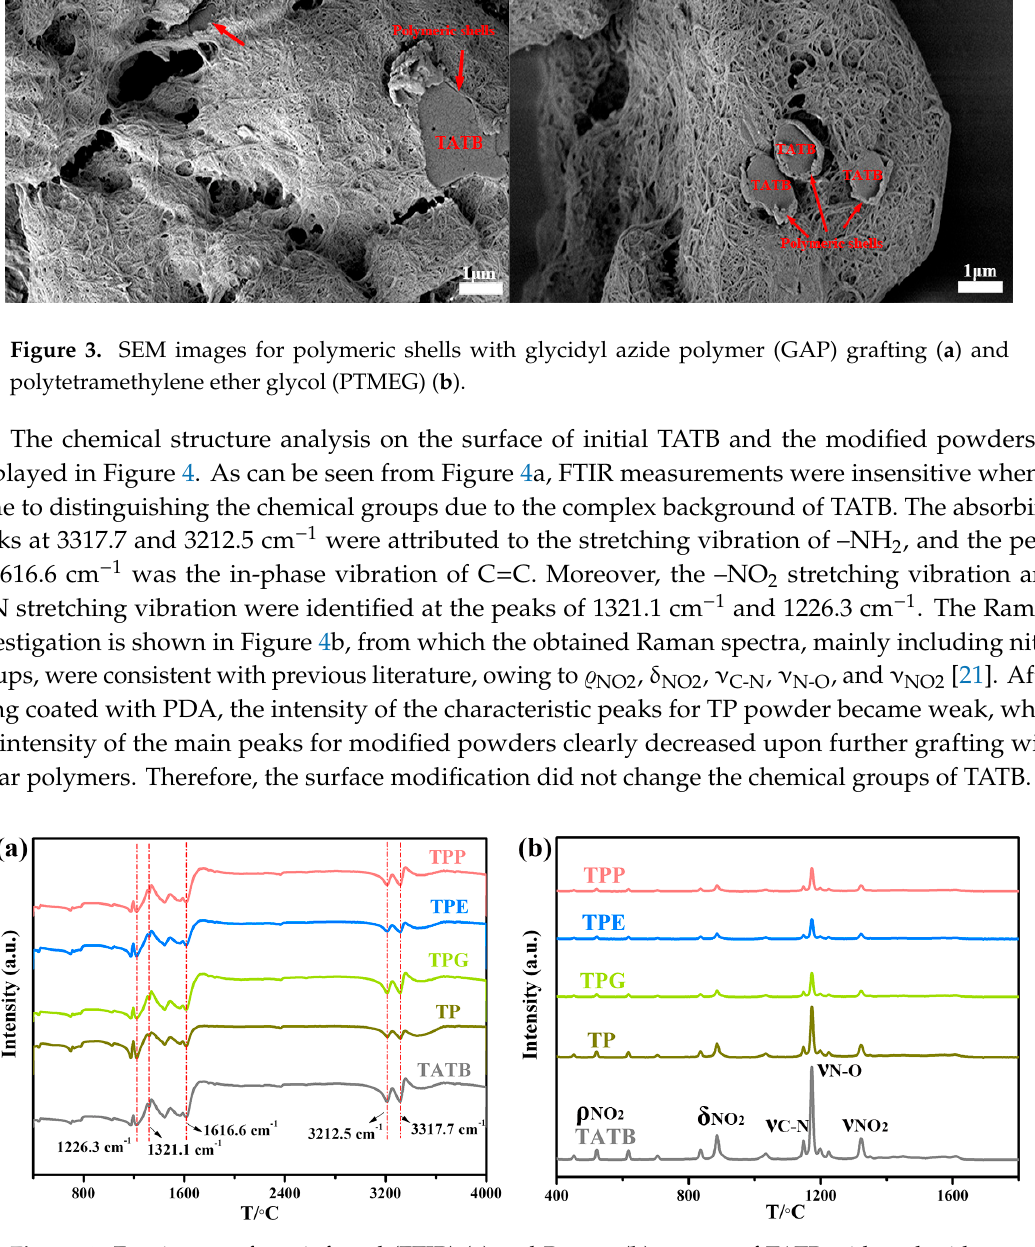
Figure 4. Fourier-transform infrared (FTIR) ( a ) and Raman ( b ) spectra of TATB with and without surface modification.